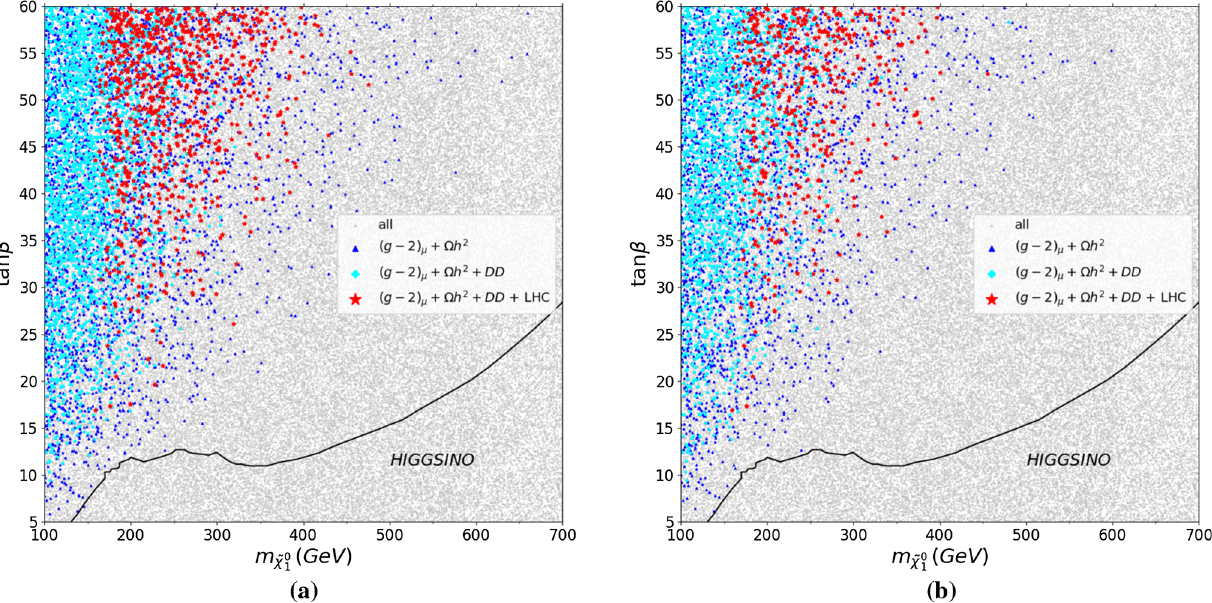
Fig. 5 The results of our parameter scan in the m ˜ χ 0 plane in the higgsino DM scenario for current (left) and antic- ipated future limits (right) from ( g − 2 ) μ . The color coding